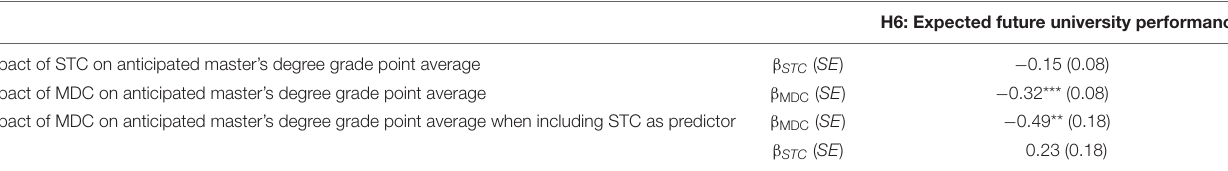
TABLE 6 | Standardized effect sizes of the impact of STC and MDC on expected future university